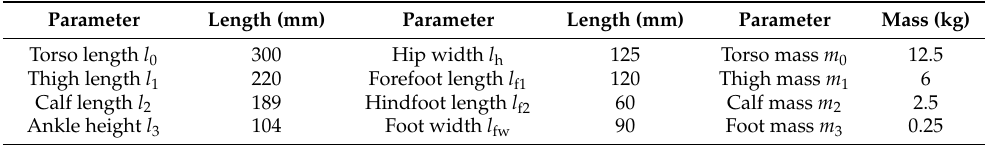
Table 4. Main parameters of the biped robot